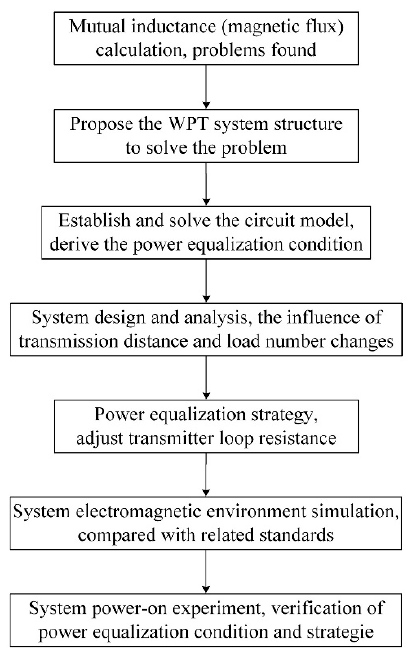
Figure 1. The block diagram of this paper. WPT—wireless power transfer.